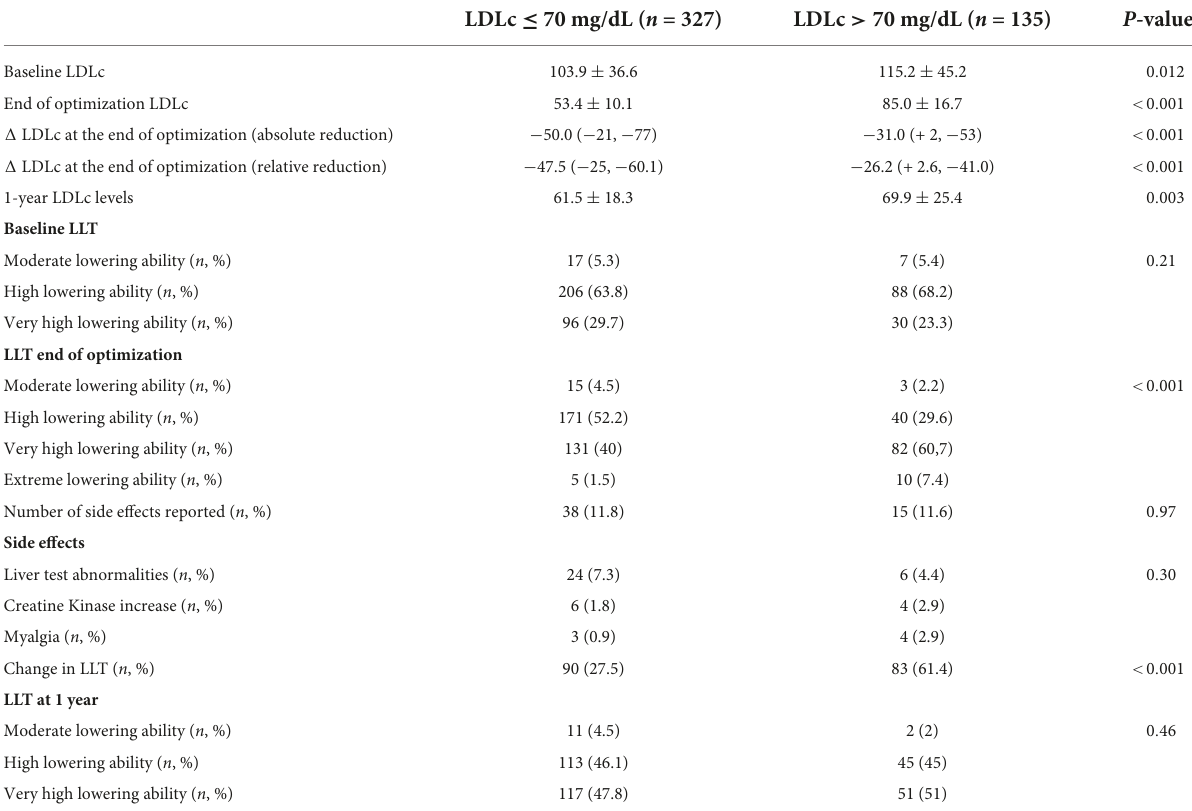
TABLE 2 Baseline LDL levels and medication changes according to LDL levels